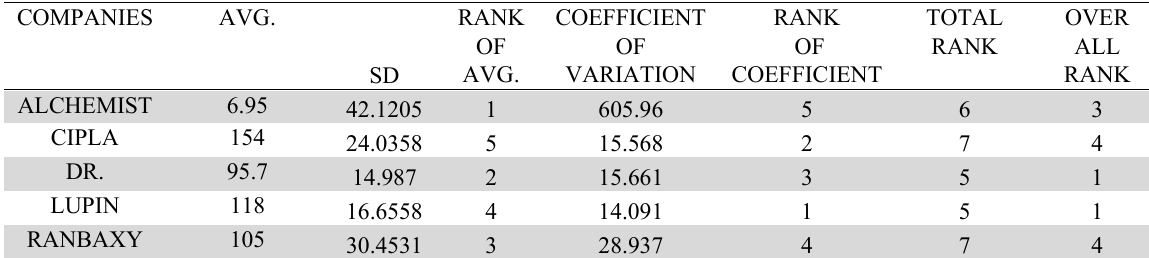
Ranking on the basis of average and consistency of cash conversion cycle of the selected companies of Pharmaceuticals